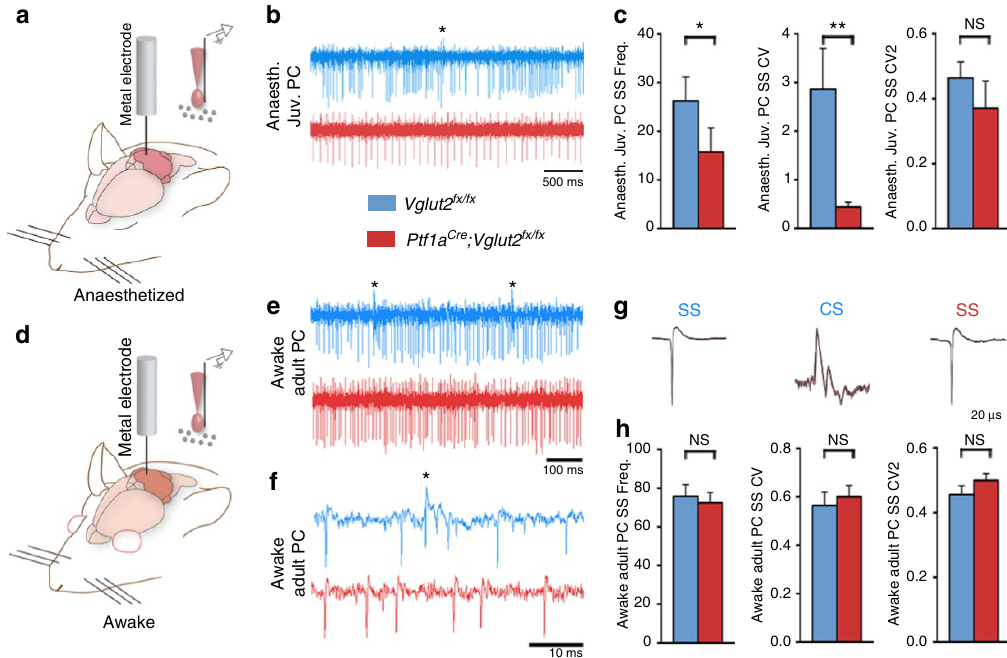
Figure 4 | Purkinje cell simple spike firing is abnormal in postnatal developing Ptf1a Cre ;Vglut2 fx/fx mutants but normalizes by adulthood. ( a ) A schematized image of the experimental procedure for extracellular recording of single units in an anaesthetized (Anaesth.) mouse and a schematized image of the electrode placement near a Purkinje cell. Schematic adapted with permission, from drawings published in refs 28,74. ( b ) Low power traces illustrating the firing properties of postnatal Purkinje cells (PC) (ages P19–P21). A complex spike is labelled with an asterisk. Scale bar 500ms. ( c ) The P19–P21 Ptf1a Cre ;Vglut2 fx/fx Purkinje cells (12 cells from 3 mice) fire slowly (frequency; P ¼ 4.1 (cid:2) 10 (cid:3) 2 ; Student’s unpaired t -test), with more overall regularity (CV, P ¼ 3.7 (cid:2) 10 (cid:3) 3 ; Student’s unpaired t -test) as compared with Vglut2 fx/fx cells (7 cells from 2 mice), but with no significant difference in local regularity (CV2, P ¼ 0.593; Student’s unpaired t -test). Error bars are defined as s.e.m. * P o 0.05 and ** P o 0.01. ( d ) A schematized image of the experimental procedure in an awake mouse and a schematized image of the electrode placement near a Purkinje cell. ( e ) Low power traces of awake Purkinje cell recordings in adult 5–8-month-old Vglut2 fx/fx and Ptf1a Cre ;Vglut2 fx/fx mice. Complex spikes are labelled with asterisks. Scale bar, 100ms. ( f ) High power traces of awake Purkinje cell recordings in adult 5–8-month-old Vglut2 fx/fx and Ptf1a Cre ;Vglut2 fx/fx mice. A complex spike is labelled with an asterisk. Scale bar 10ms. ( g ) Sample waveform averages of simple spikes (SS) from adult 5–8-month-old Vglut2 fx/fx and Ptf1a Cre ;Vglut2 fx/fx mice and complex spikes (CS) from Vglut2 fx/fx mice. ( h ) Simple spike firing was unchanged in terms of frequency, CVand CV2 in awake, adult Ptf1a Cre ;Vglut2 fx/fx mice as compared with Vglut2 fx/fx mice (respectively: P ¼ 0.695; P ¼ 0.622; P ¼ 0.204; ages 5–8 months; n ¼ 18 Vglut2 fx/fx cells from 7 mice and